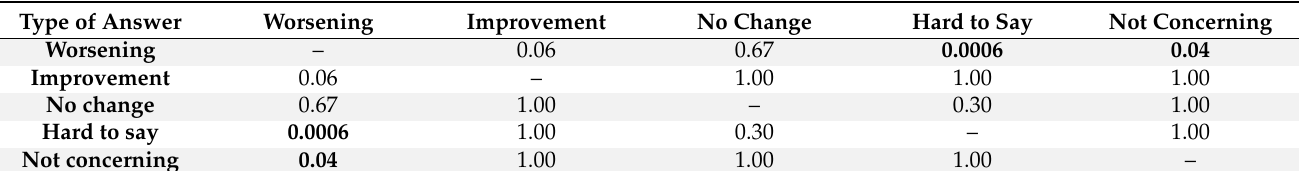
Table 3. Differences between an overall number of respondents for each answer in questions related to ED symptoms and eating behaviors changes due to the COVID-19